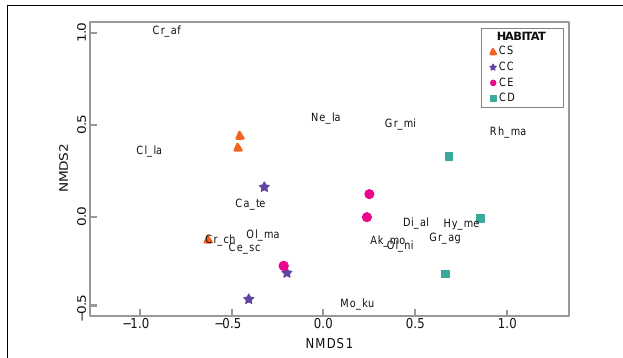
FIGURE 3 | Non-metric multidimensional scaling (NMDS) for small mammal abundances during the 2017–2018 survey. Small mammal species are: